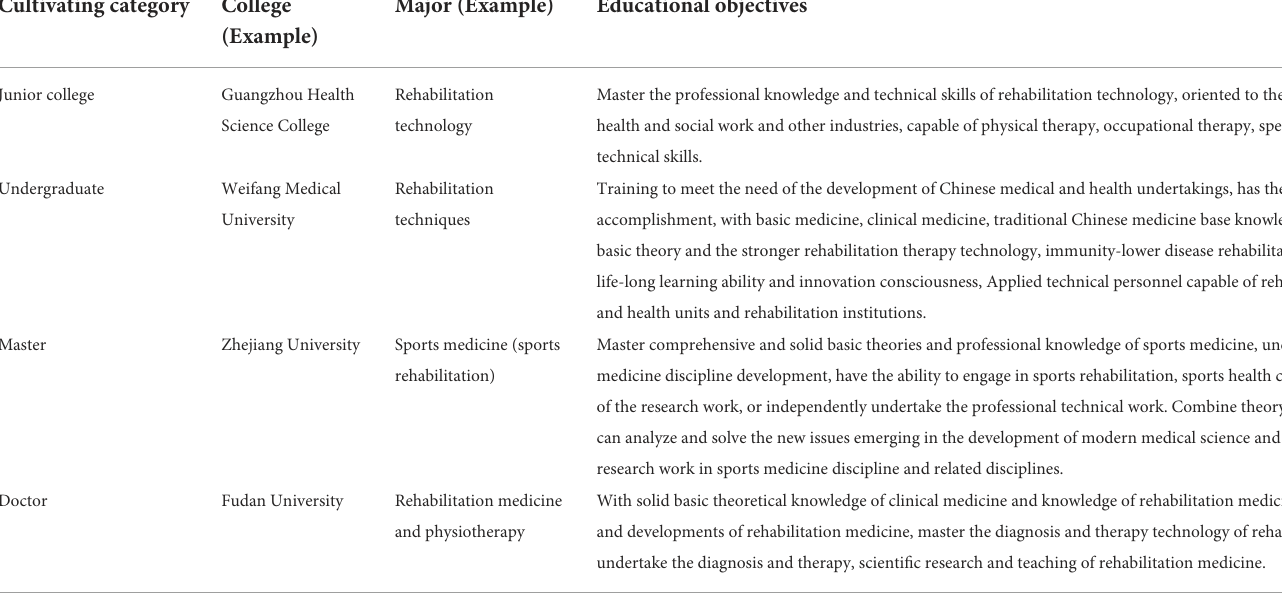
TABLE 1 Educational objectives of each training level of